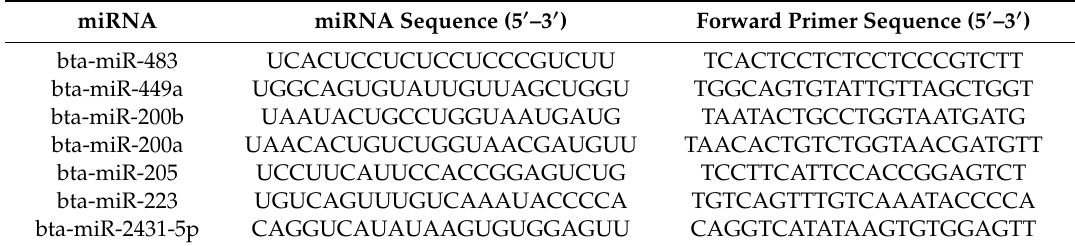
Table 2. MiRNA primers for quantitative real-time